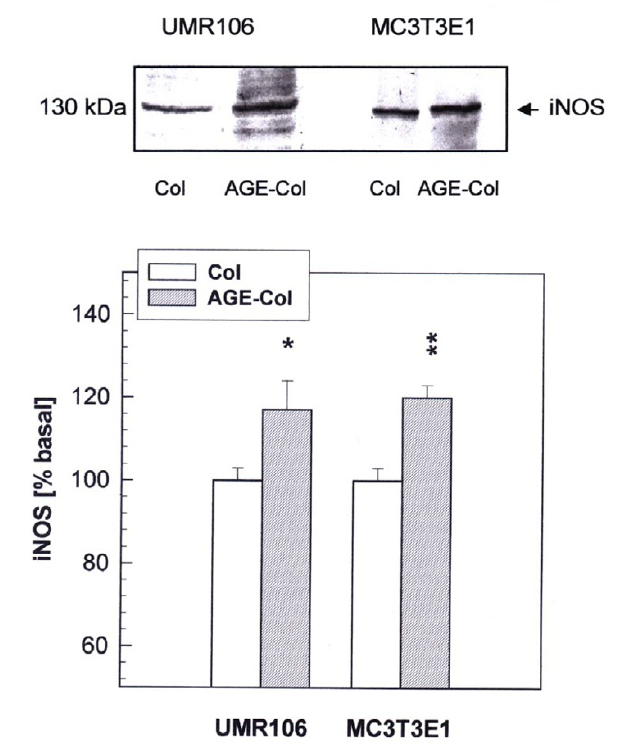
Figure 8 Effect of AGE-modified type I collagen on the expression of iNOS in osteoblast-like cells. UMR106 and MC3T3E1 cells were cultured on control or AGE-modified type I collagen matrices at 37 ° C for 24 hours. After this incubation, cell monolayers were lysated in Laemmli's buffer and electro- phoresed under reducing conditions on an 8 % SDS-PAGE. Western blotting was performed, and specific bands were detected using a rabbit polyclonal antibody against iNOS. A representative blot from three independent experiments is presented (top figure). Images were scanned and analyzed by densitometry. The relative intensity of each band is shown (bottom figure) as a percentage of the corresponding basal condition (unmodified collagen), and represents the mean ± SEM. Differences between collagen vs. AGE-collagen are as follows: * p<0.05; **